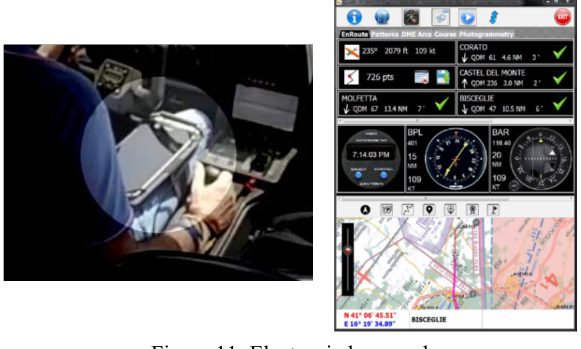
Figure 11. Electronic knee pad